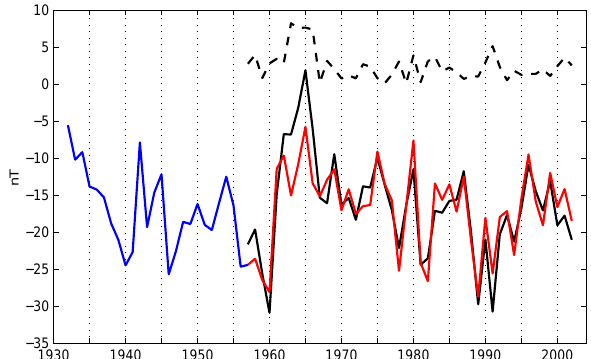
Fig. 4. Annual average range of the diurnal UT variation in the reconstructed D st in 1932–1956 (blue), in 1957–2002 (red) and in the original D st in 1957–2002 (black). All hourly values were in- cluded.